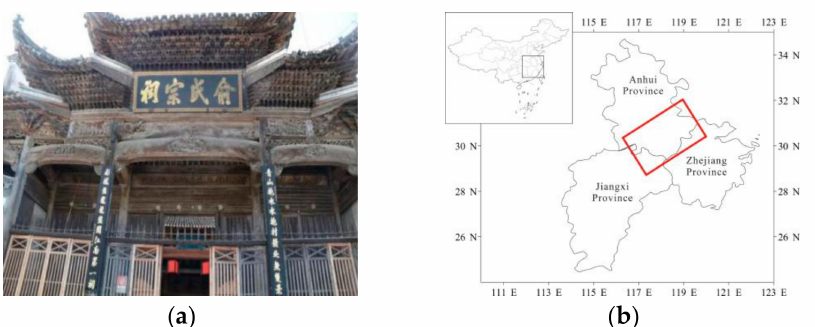
Figure 1. ( a ) The typical Huizhou-style ancient architecture, ( b ) the sketch map of China showing the distribution area of ancient Huizhou-style architectures (in red